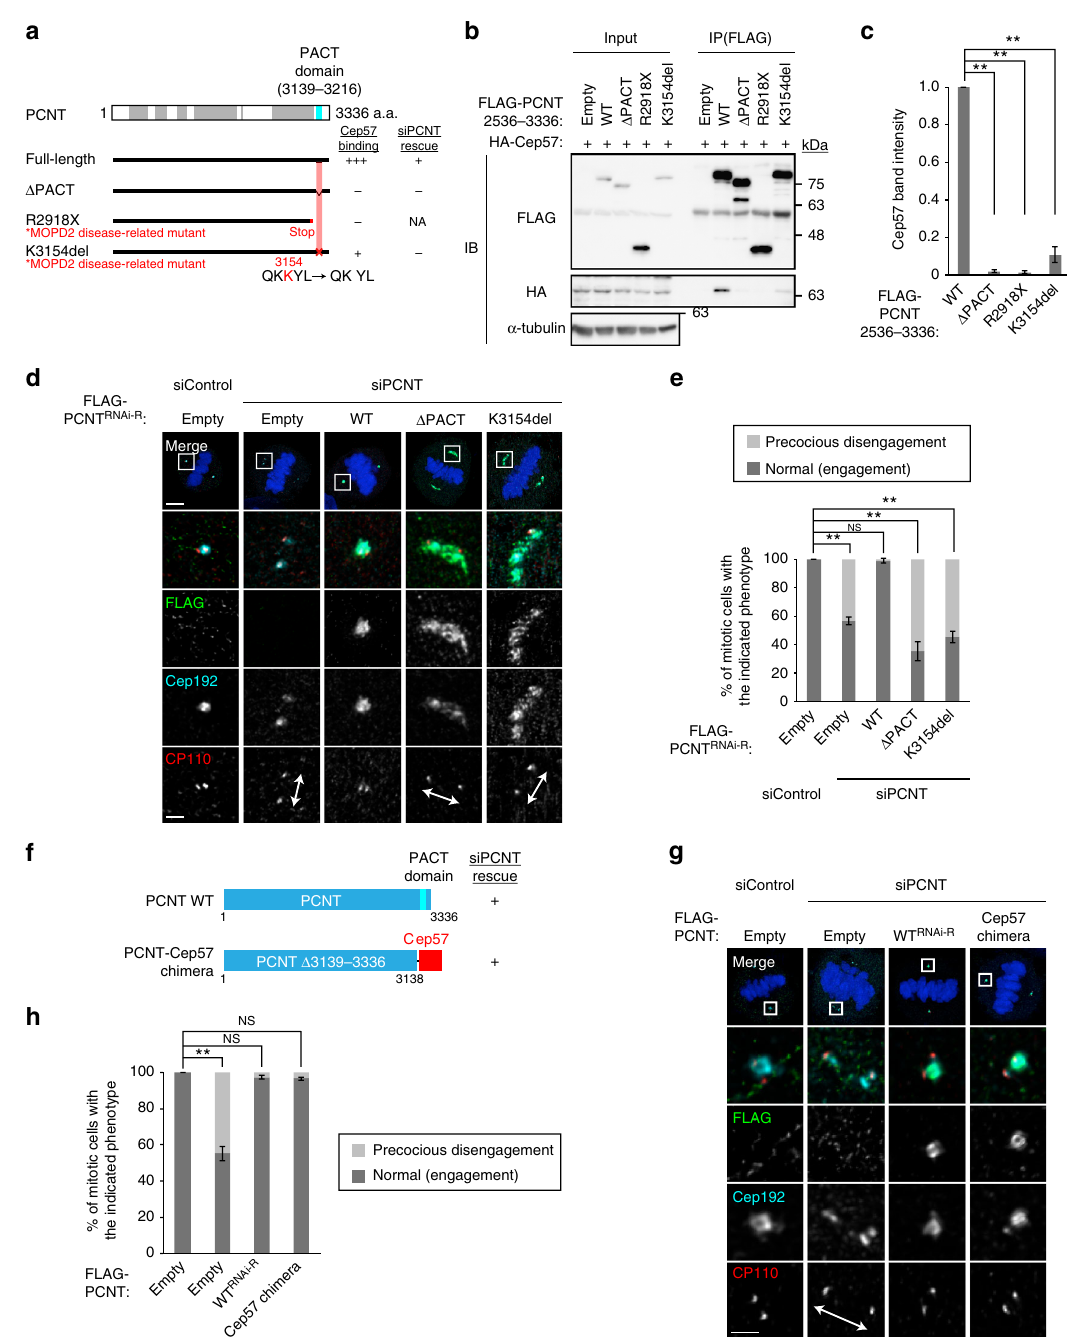
FLAG- PCNT RNAi-R :